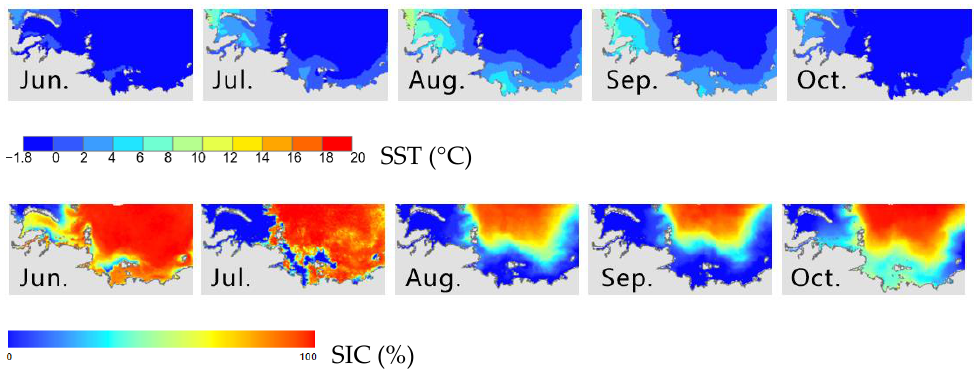
Figure 18. Monthly mean of SST and SIC in Northern Siberia from June to October 2002 to 2021. Changes in SST are not the only factor delaying the freezing of sea ice. Climate change will also push more warm Atlantic water towards the Arctic, affecting ice formation, transpolar drift across the Arctic Basin from Eastern Siberia and the Laptev Sea to the Fram Strait and the anticyclonic Beaufort Gyre in the Canada Basin [71]. The Arctic circu-